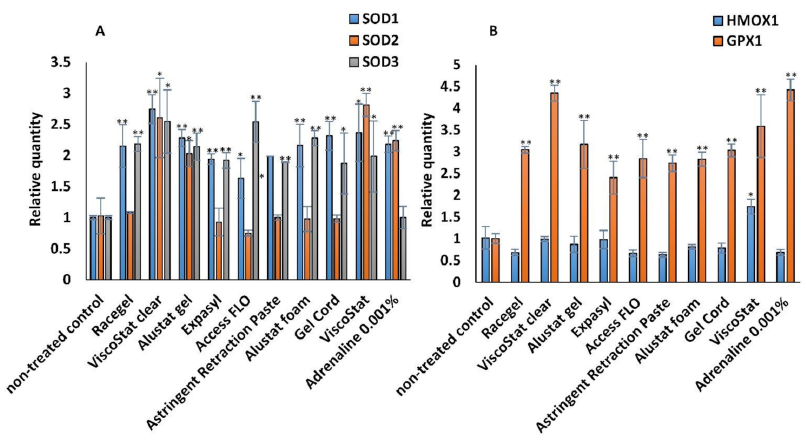
Figure 5. The RNA expression levels of: ( A ) SOD1, SOD2, and SOD3; and ( B ) HMOX1 and GPX1 detected by real-time RT-PCR in human gingival fibroblasts after 24 h of incubation with the gingival retraction agents diluted in the cell culture medium to 1 mg/mL concentration; * p < 0.05, ** p <